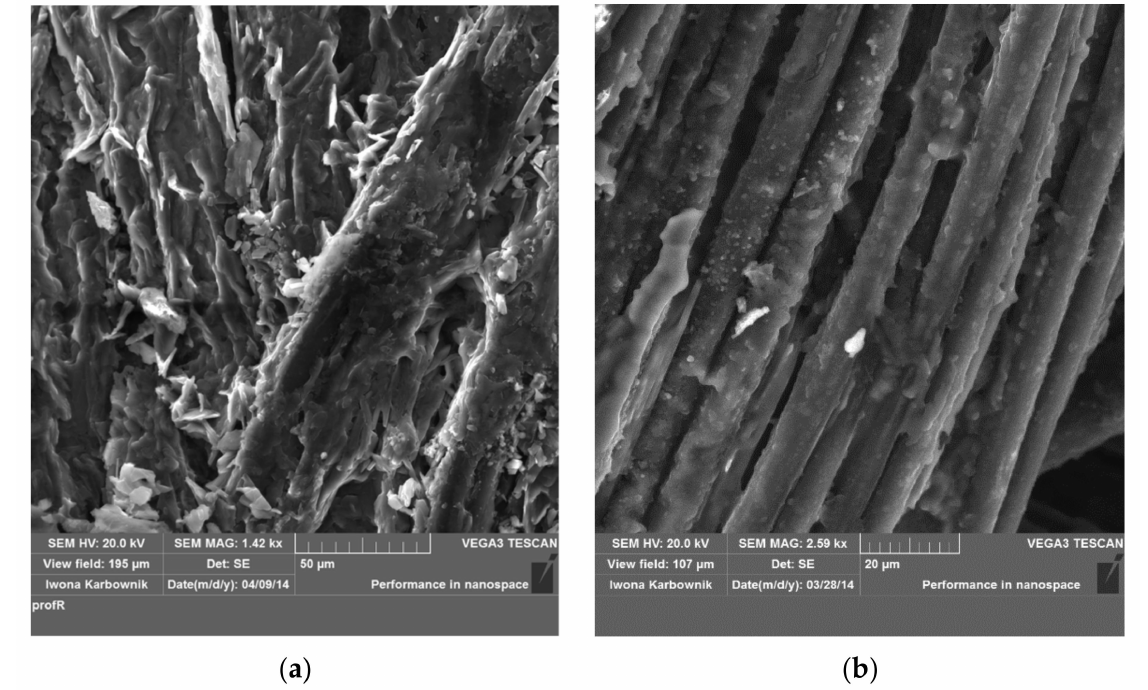
Figure 6. SEM images of: ( a ) Five layers of PANI; ( b ) five layers of PPy inkjet printed on PAN